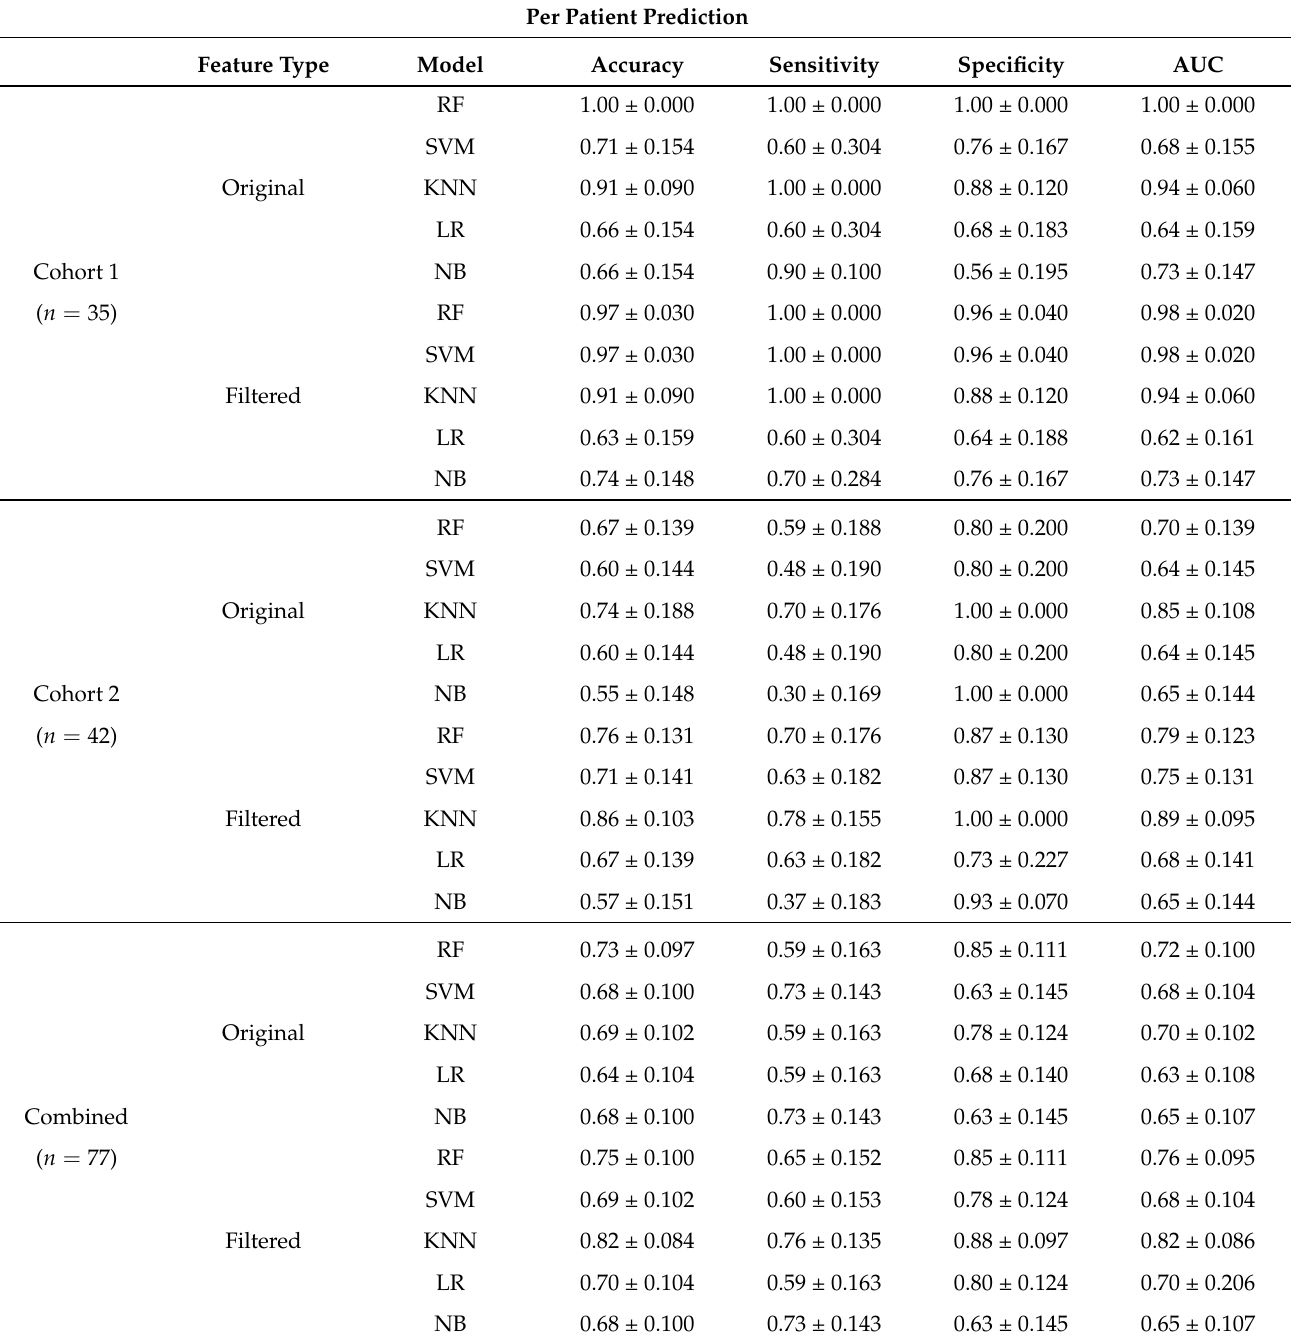
Table 9. Representation of diagnostic performance using per patient prediction from all tumor slices using majority voting technique for different